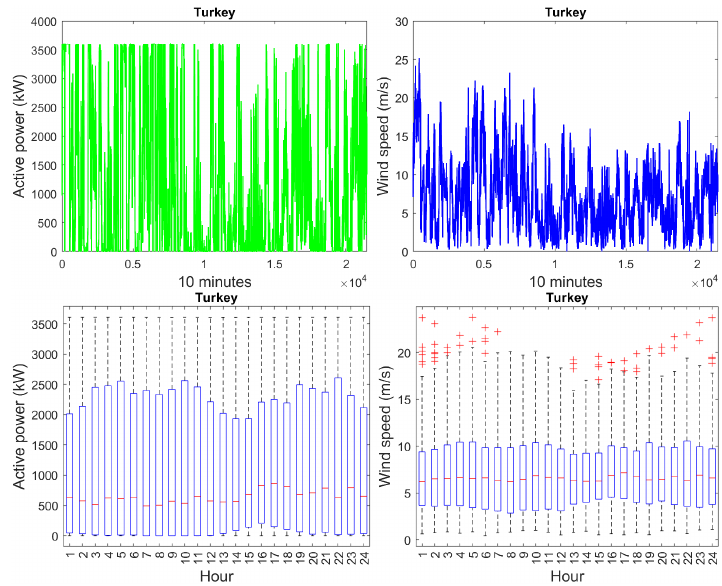
Figure 4. Wind power ( top left ) and wind speed ( top right ) data from Turkey wind turbine; box plot of hourly data for wind power ( bottom left ) and wind speed ( bottom right